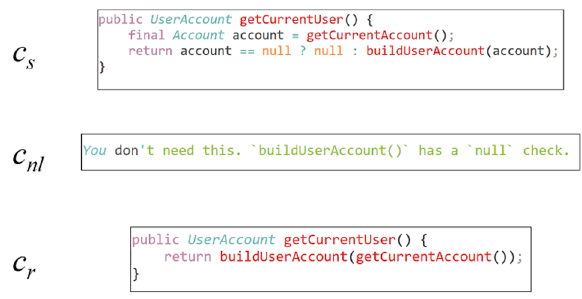
Figure 5. A sample in a